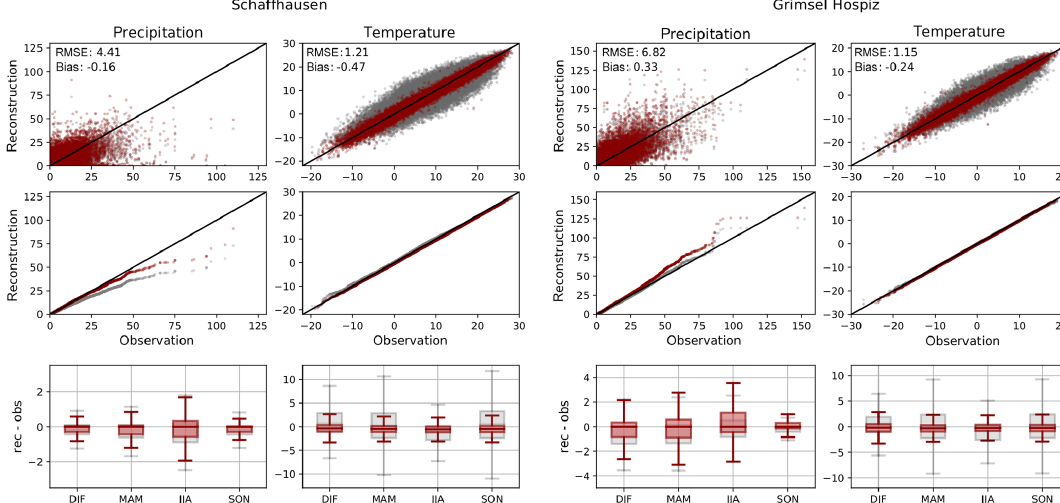
Figure 7. Comparison between reconstructions and station observations of precipitation (mm) and temperature ( ◦ C) for Schaffhausen (left) and Grimsel Hospiz (right) with ARM reconstructions (grey) and post-processed data (red). Shown are observed vs. reconstructed values (top), quantile–quantile plots (centre), and box plots of the deviation between the reconstruction and observation by season